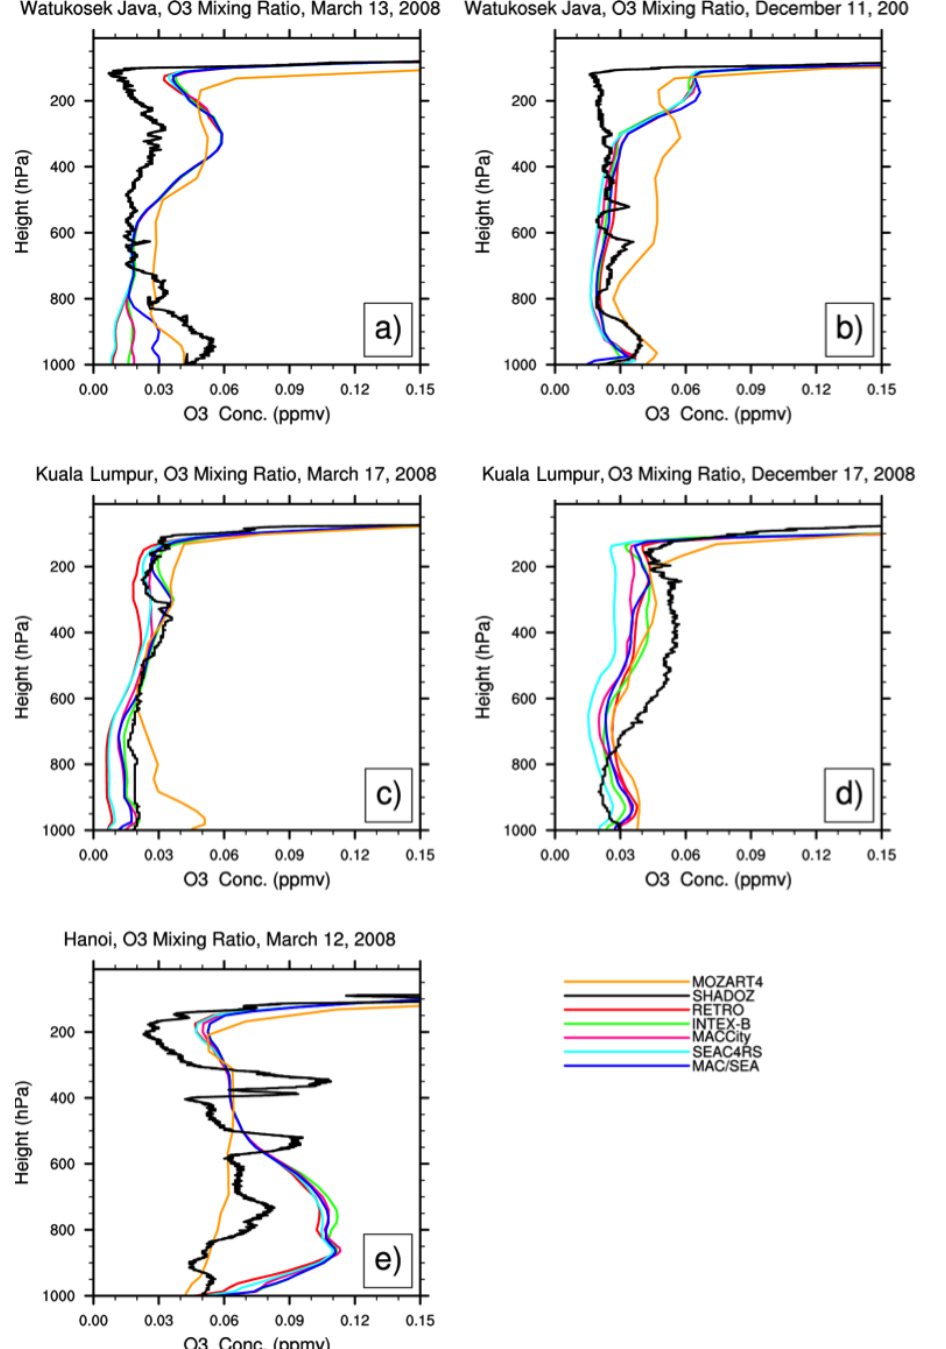
Figure 13. O 3 vertical profiles from WRF-Chem, MOZART4, and ozonesondes at three SHADOZ ozonesonde locations for (a) Watukosek- Java, Indonesia in March, (b) Watukosek-Java, Indonesia in December, (c) Kuala Lumpur, Malaysia in March, (d) Kuala Lumpur, Malaysia in December, and (e) Hanoi, Vietnam in March. Note that there are no SHADOZ data at Hanoi during December 2008.